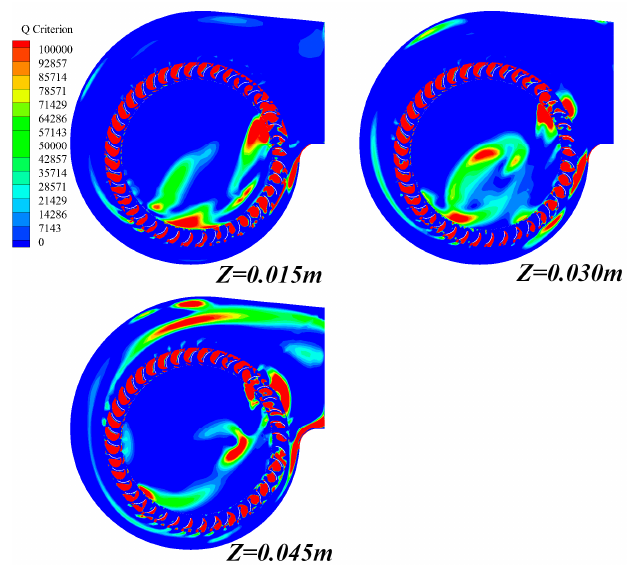
Figure 13. Q value distribution of cross-sections at di ff erent positions (Q / Qn = 1).